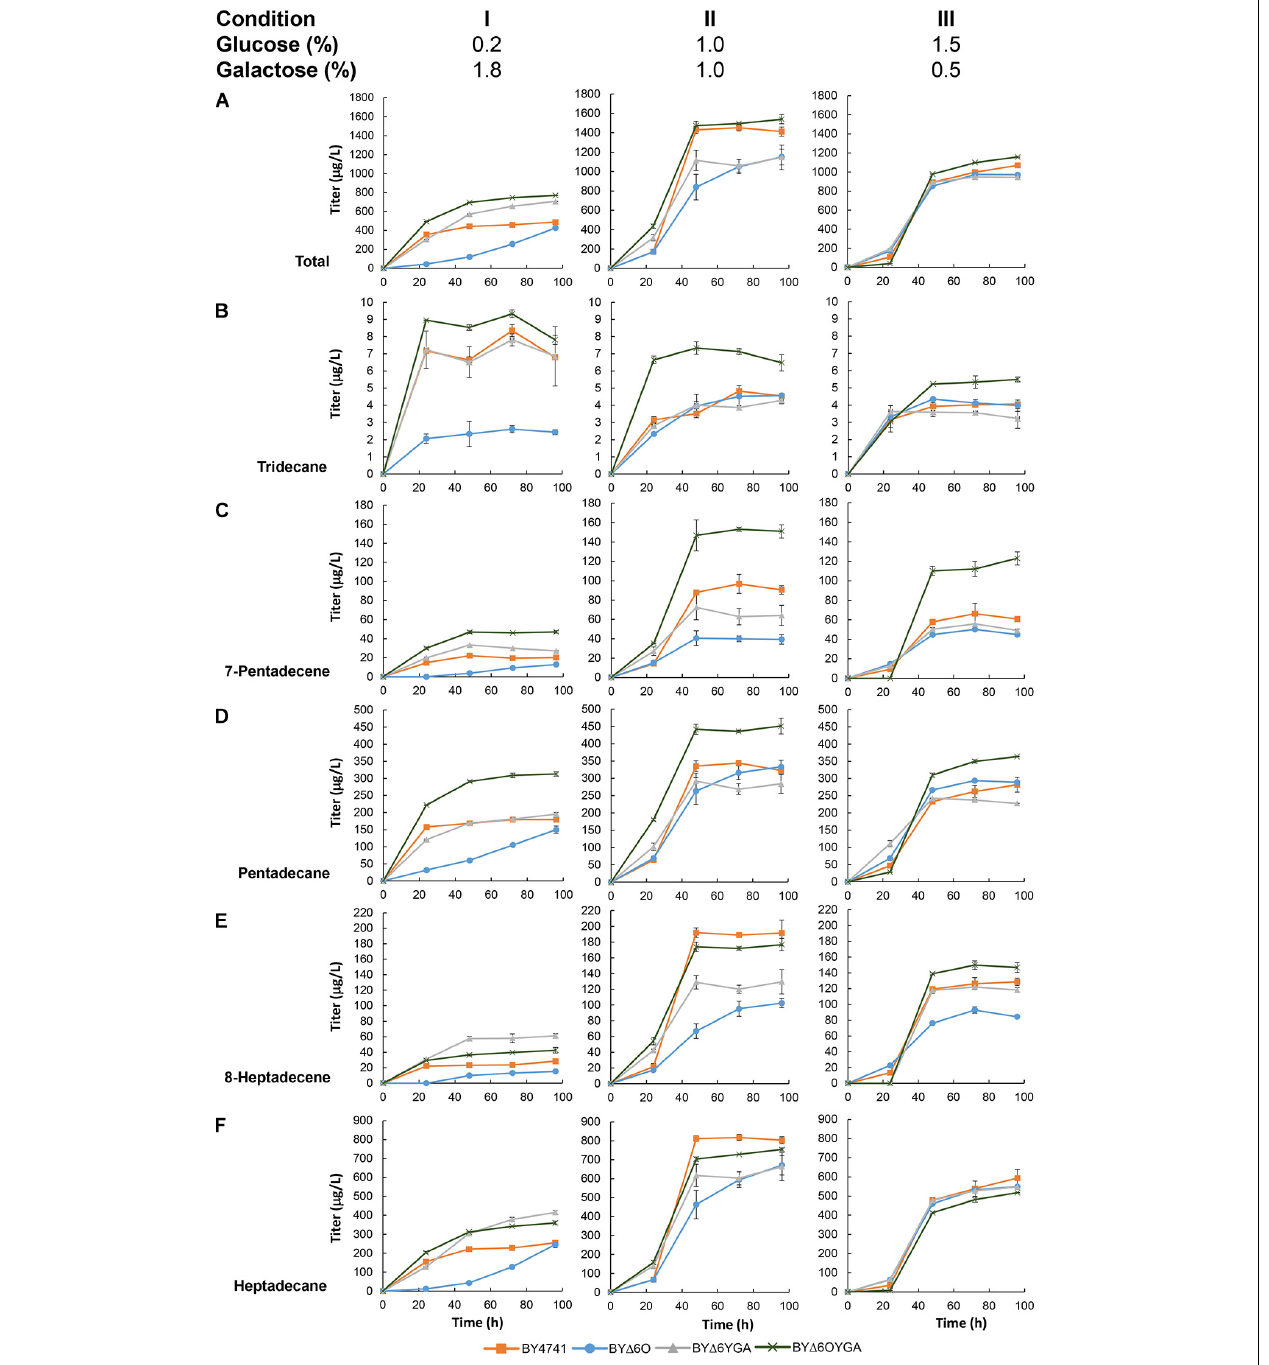
FIGURE 5 | De novo alkane and alkene (ALK) production via a fatty acyl-CoA-dependent pathway in various Saccharomyces cerevisiae mutants. Time profiles of the ALK titers from different glucose/galactose ratio in BY4741, BY (cid:49) 6O, BY (cid:49) 6YGA, and BY (cid:49) 6OYGA harboring a fatty acyl-CoA-dependent ALK biosynthesis pathway are shown. Total titers (A) as well as the titers of individual ALK components, i.e., (B) tridecane, (C) 7-pentadecene, (D) pentadecane, (E) 8-heptadecene, and (F) heptadecane are presented. Data are shown as the mean ± SD of biological